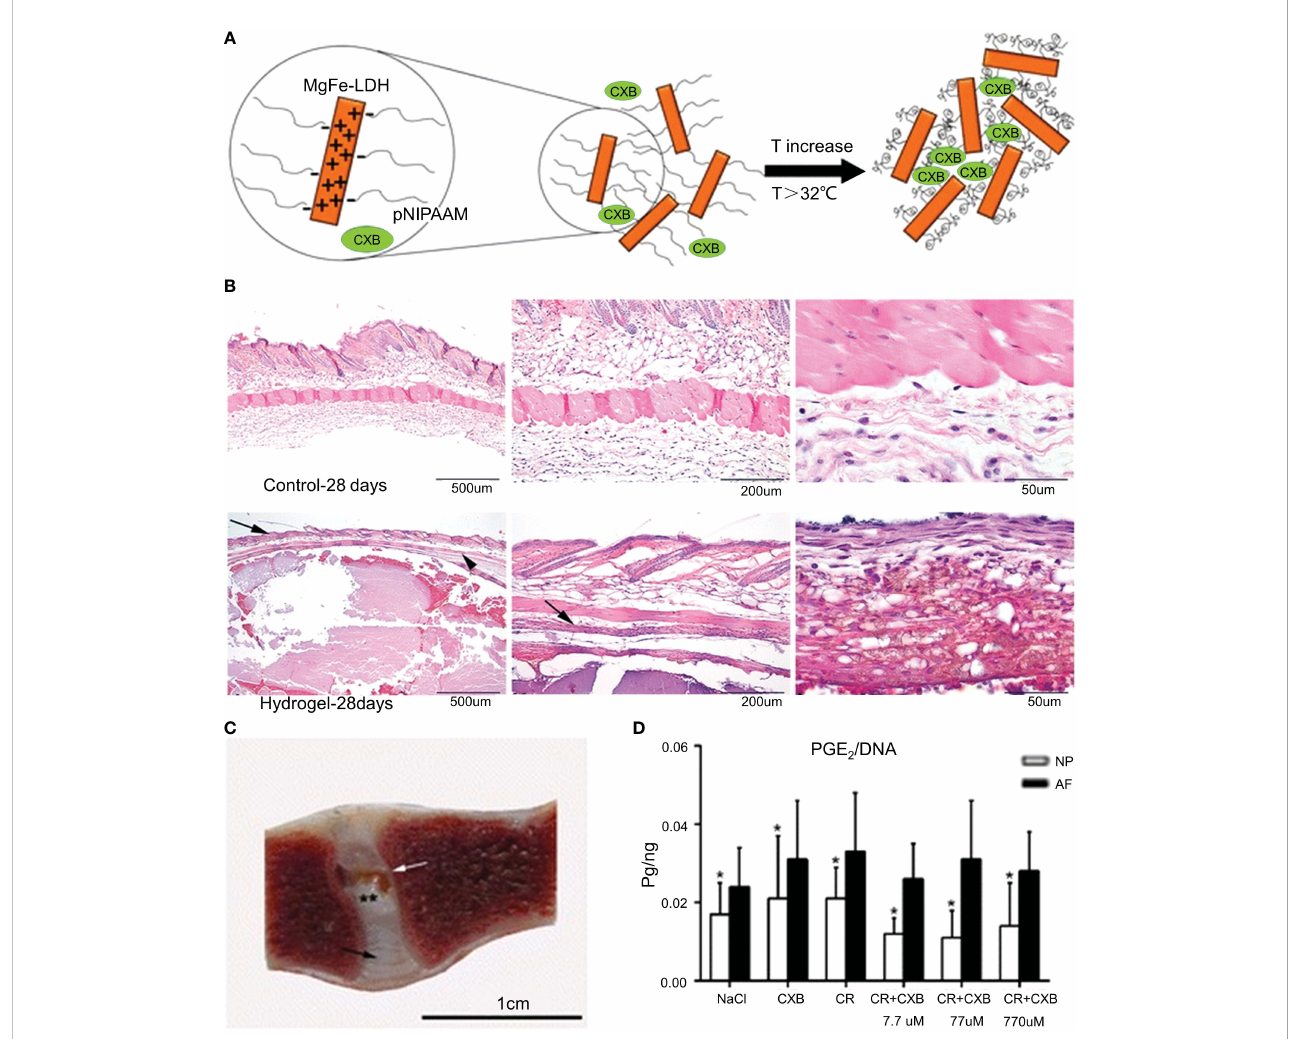
FIGURE 5 (A) Schematic diagram of the synthesis of the pNIPAAM hydrogel. (B) Histological staining (hematoxylin and eosin staining) of the hydrogel and control group after 28 days in mice. The epidermis and fl esh lipid membranes are indicated by the arrows. (C) One month after the intradiscal injections, the pNIPAAM hydrogel (white arrow) was visible in the NP. (D) The DNA level in PGE 2NP was signi fi cantly lower than that in AF in all treatments. Reproduced with permission from (50). *Indicates signi fi cant difference at a 99 % con fi dence level P ≤ 0.05. **Indicates signi fi cant difference at a 99 % con fi dence level P ≤